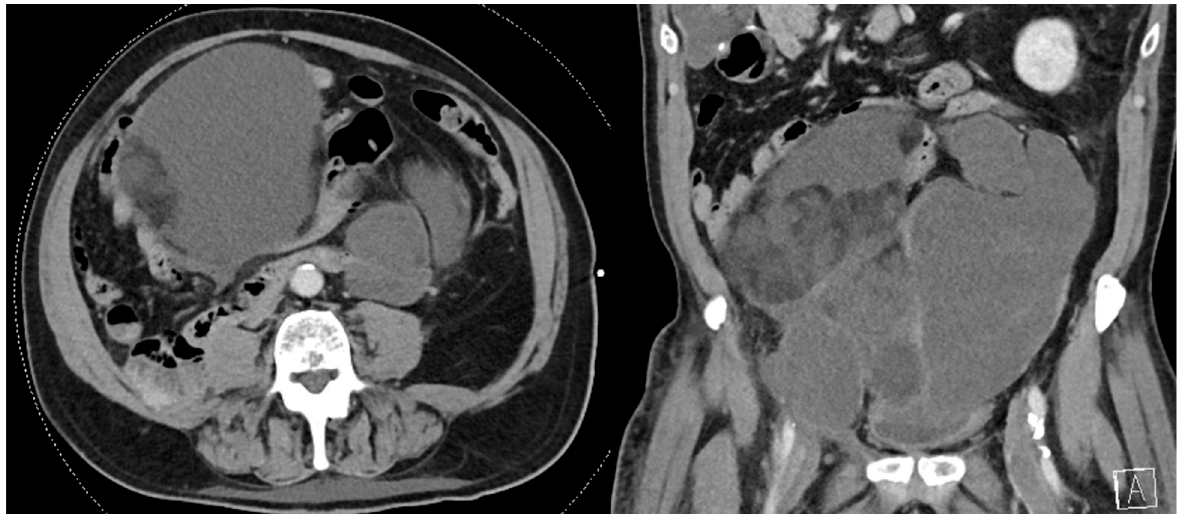
Figure 1. Recurrent multifocal de-differentiated liposarcoma requiring en bloc small bowel resection, sigmoid colectomy, and end colostomy. The index operation required en bloc right colectomy, right nephroureterectomy, right adrenalectomy, partial right psoas muscle resection, and right spermatic cord resection.